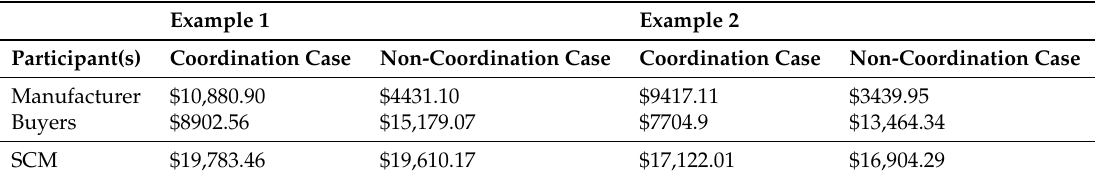
Table 7. Comparative study between the coordination and non-coordination cases.